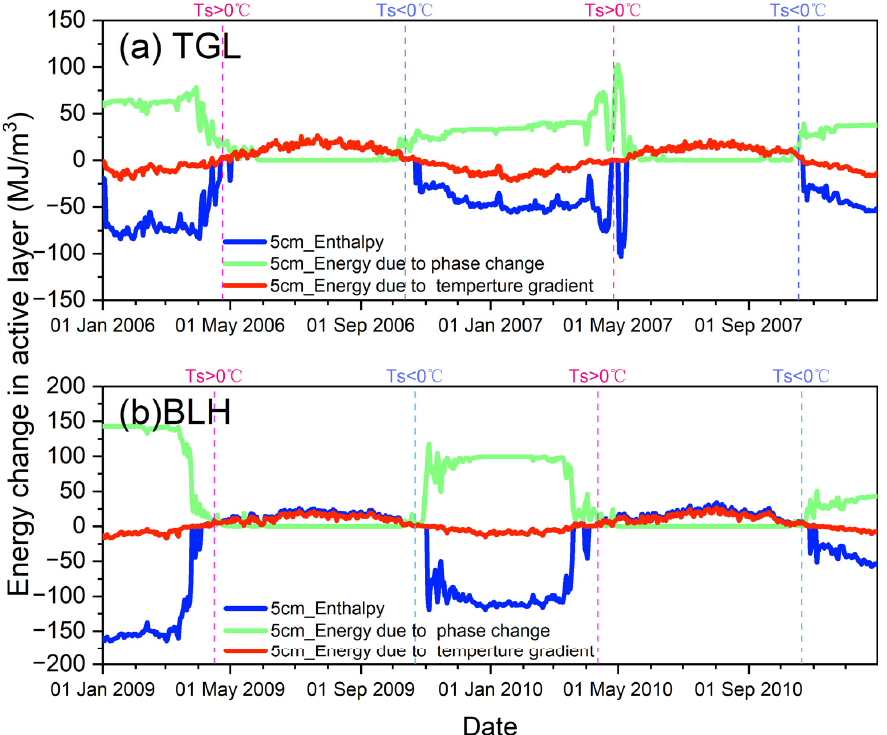
Figure 8. The energy changes in a 5 cm thickness of soil.